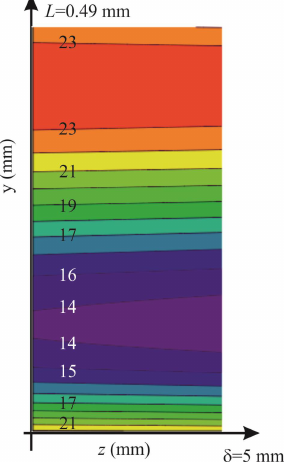
Fig.6. Two dimensional temperature distributions of the vehicle’s windscreen determined by the Trefftz method.